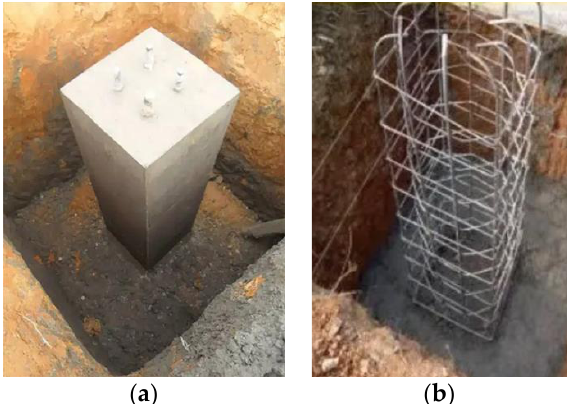
Figure 1. Reinforced concrete foundation ( a ) Outward appearance; ( b ) Internal rebar cage (The cross-sectional dimension of the reinforced concrete foundation is mainly in the form of 0.8 m × 0.8 m to 1.2 m × 1.2 m. The column height is 3m to 5 m. The main rebars inside the foundation are made of round steels).